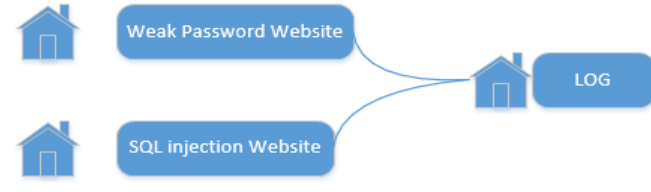
Figure 2. The framework of system architecture.